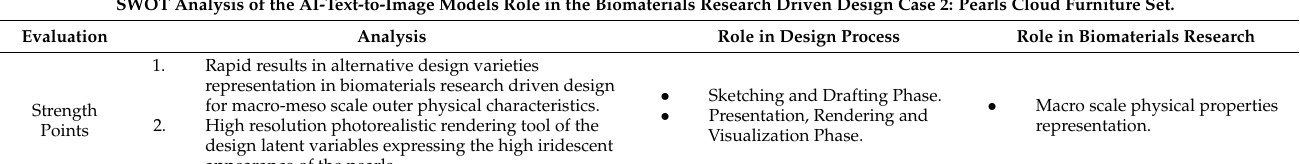
Table 2. The pearl cloud chair seashell-based biocomposite material from food waste: SWOT